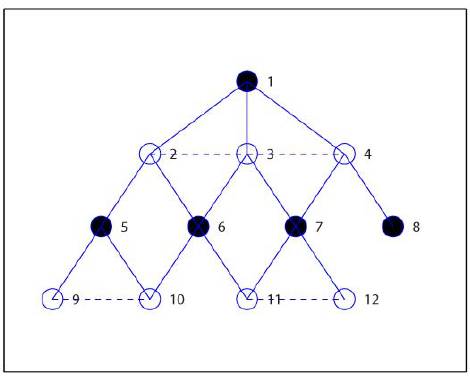
Figure 4. MIS construction for the given